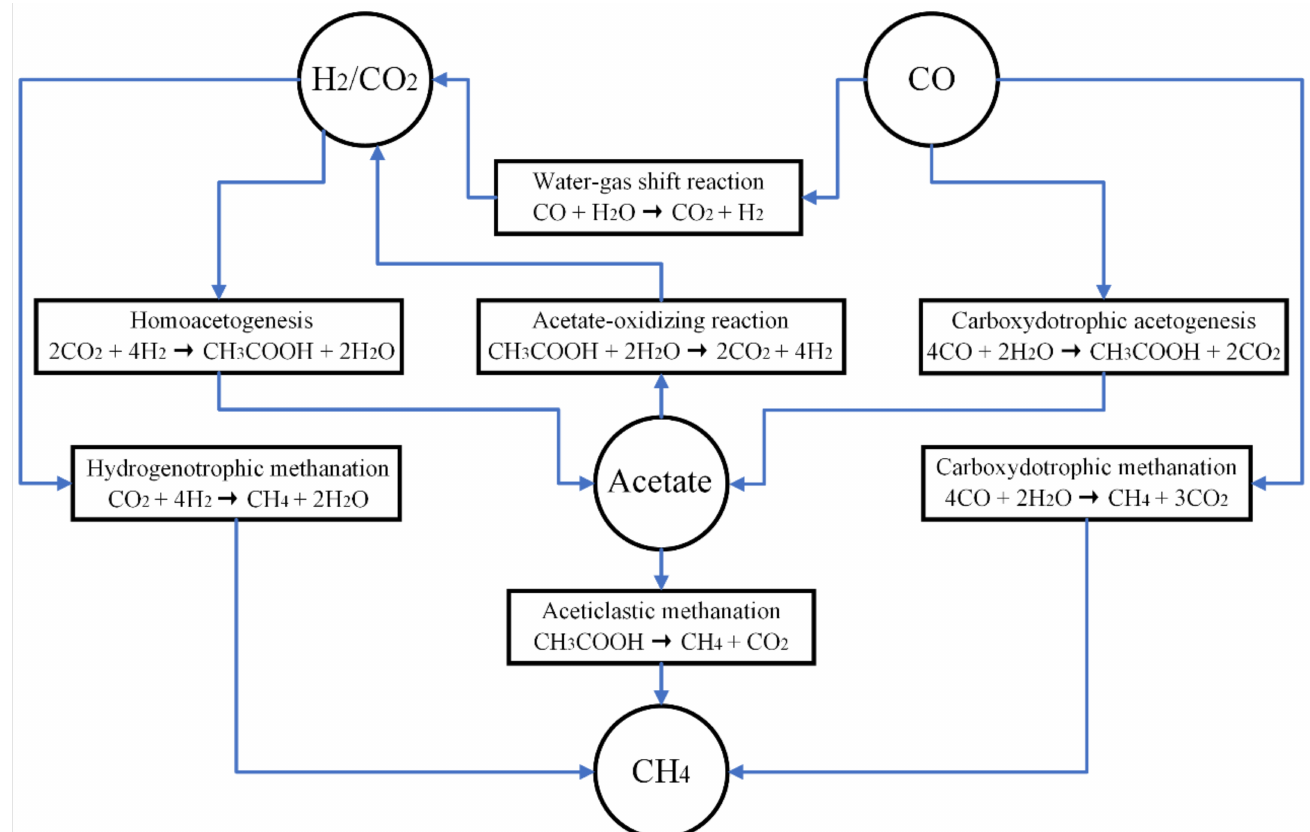
Figure 1. Major pathways of syngas biomethanation